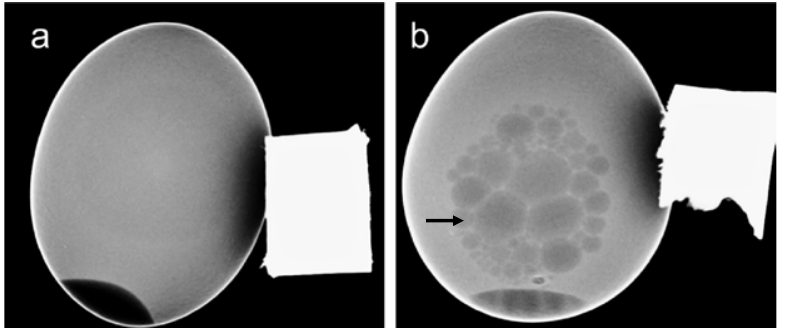
Fig. 3. X ray imaging of SPIONs a) without SPIONs b) with SPIONs. The black arrow denotes the egg yolk (which is clearly seen in SPIONs loaded